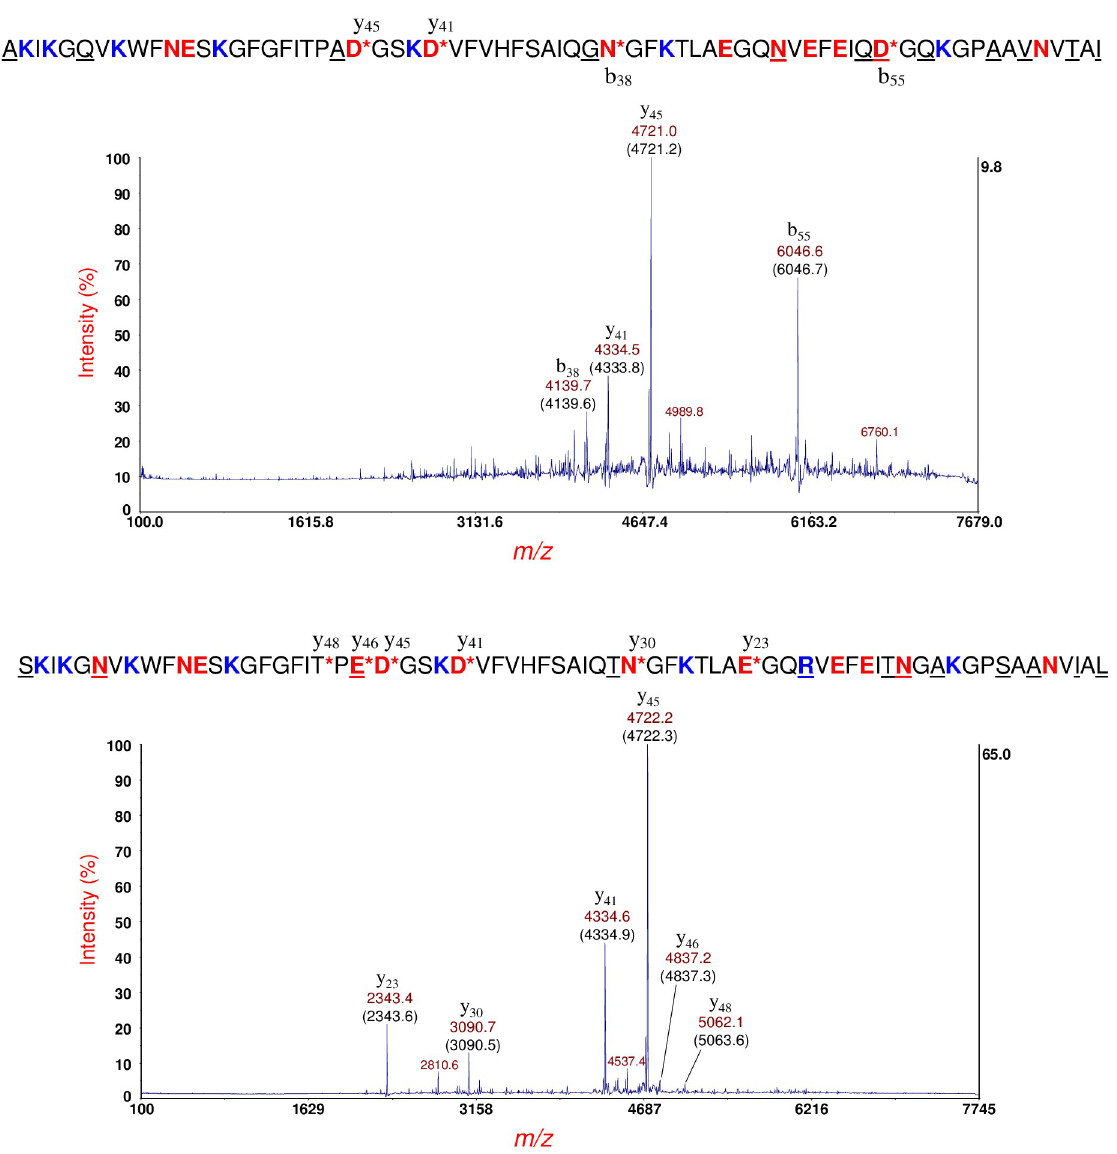
Fig 6. Top panel: MS/MS of the putative CspC at m/z 7272 [M+H] + (Fig 4, middle panel). CspC sequence is shown above (without its N- terminal methionine) and underlined residues highlight differences in amino acid sequence between CspC and CspE (shown below). An asymmetric TIS window of -100/+30 was used to eliminate spillover of fragment ions of the putative metastable CspE ion. Bottom panel: MS/MS of the putative CspE at m/z 7333 [M+H] + (Fig 4, middle panel). CspE sequence is shown above (without its N-terminal methionine). Underlined residues highlight differences in amino acid sequence between CspE and CspC (shown above). The TIS window was reversed (-30/+100) from its setting for CspC to eliminate fragment ion spillover of metastable CspC ion.